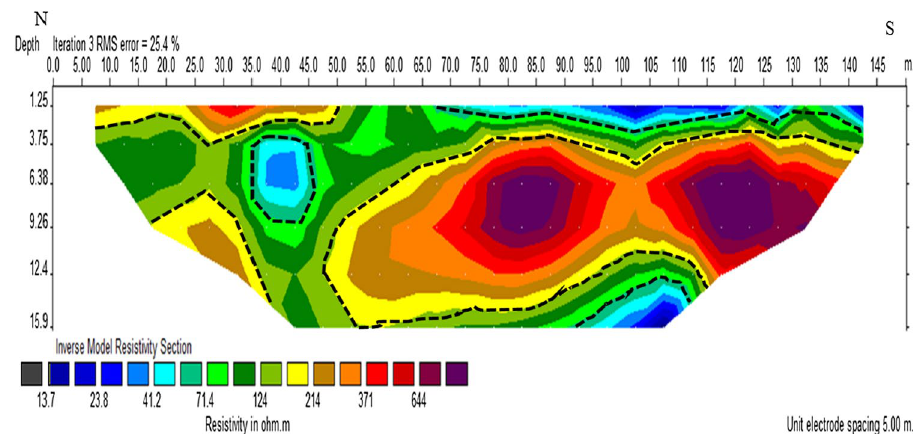
Fig. 6 Pseudosection of